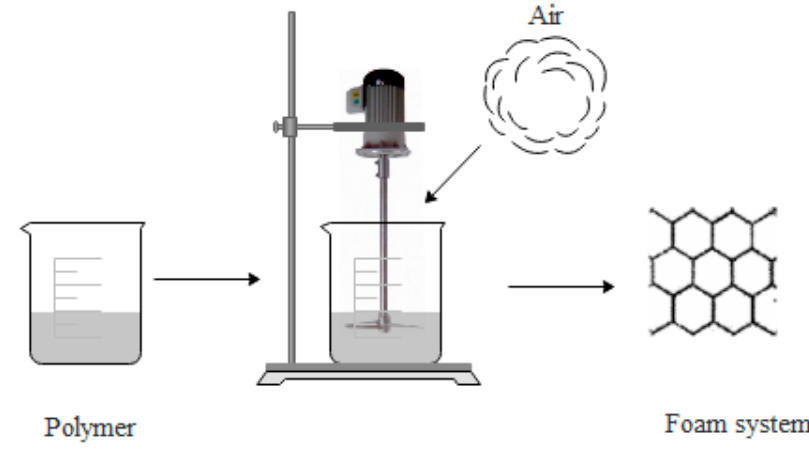
Figure 2. Schematic diagram of mechanical foaming.